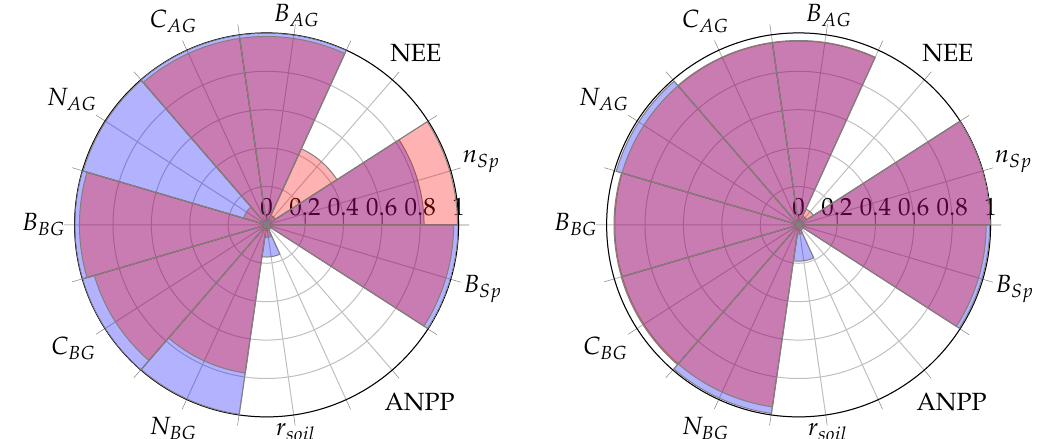
Figure 5. Overall model performance ( R 2 ) for both models and sites; left = HF-EMS; right = JERC-RD; periwinkle = PPA-SiBGC; pink = LANDIS-II NECN; violet = intersection. On average, PPA-SiBGC outperformed LANDIS-II NECN across the sites and metrics tested, showing higher correlations, lower error, and less bias overall (HF-EMS R 2 = 0.73, + 0.07, RMSE = 4.68, − 9.96, ME = − 0.84, − 5.96; JERC-RD R 2 = 0.73, + 0.01, RMSE = 2.18, − 1.64,